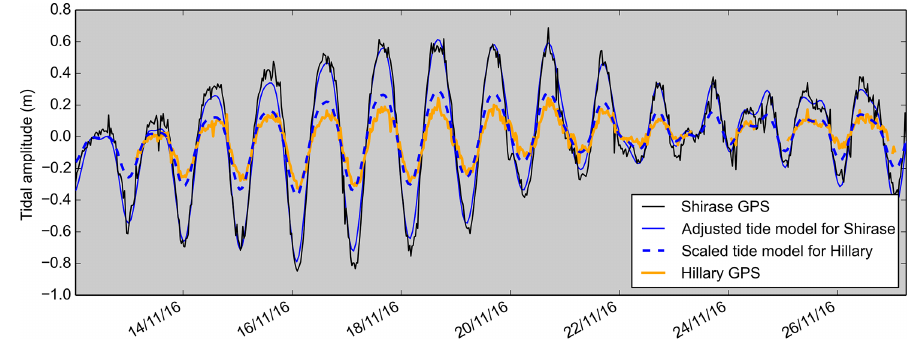
Figure 7. Time series of vertical tidal displacement on the freely floating part of the Darwin Glacier (Shirase) and within the flexure zone close to the grounding line (Hillary) . The (solid blue) corrected tide-model output for the Shirase location is at first compared to (black) its corresponding GPS record. The (dashed blue) extended tide model is scaled and shows an empirical prediction for (orange) the GPS record at the flexure-zone station Hillary. The length of the record corresponds to the grey-shaded area in Fig.